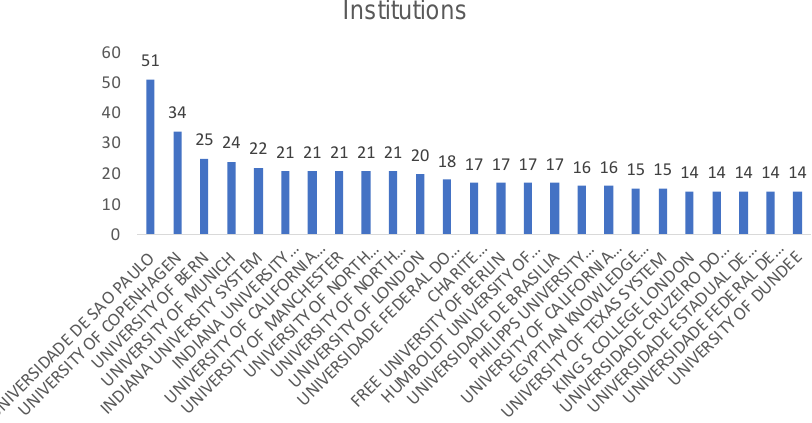
Figure 6. Institutions with the highest number of publications.